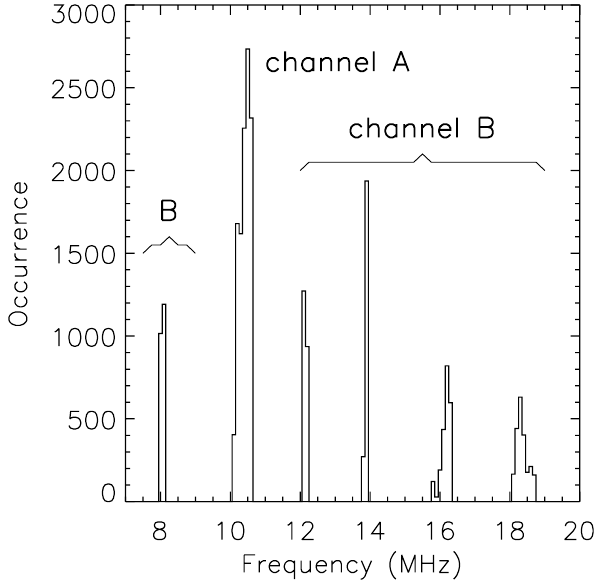
Fig. 1. Occurrence of transmission at different operating frequen- cies by the Iceland East radar during 18:00–06:00UT, 14–15 De- cember 2001. Channel A of the Stereo system transmitted near 10MHz, whereas the transmissions of channel B were split between five frequency bands near 8, 12, 14, 16, and